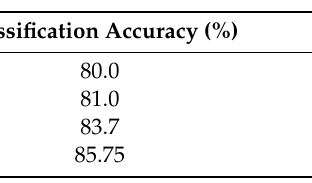
Table 7. Comparison of the proposed method with other state-of-the art methods using the Corel-10k